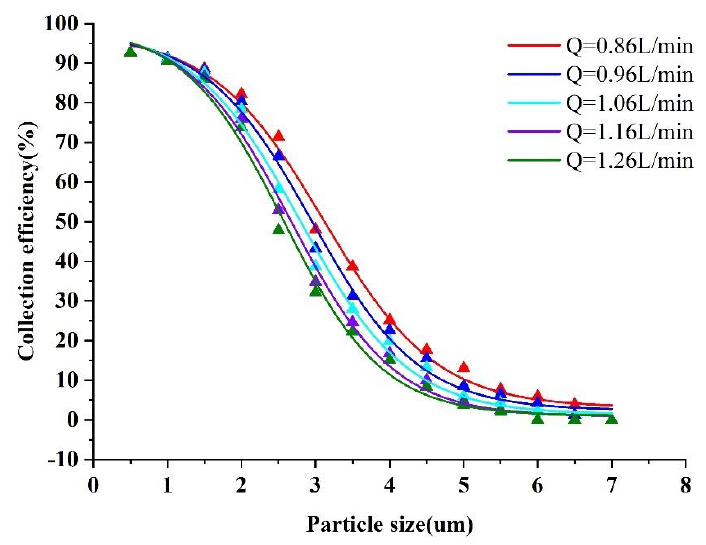
Figure 6. Collection efficiency curves at different Q values.